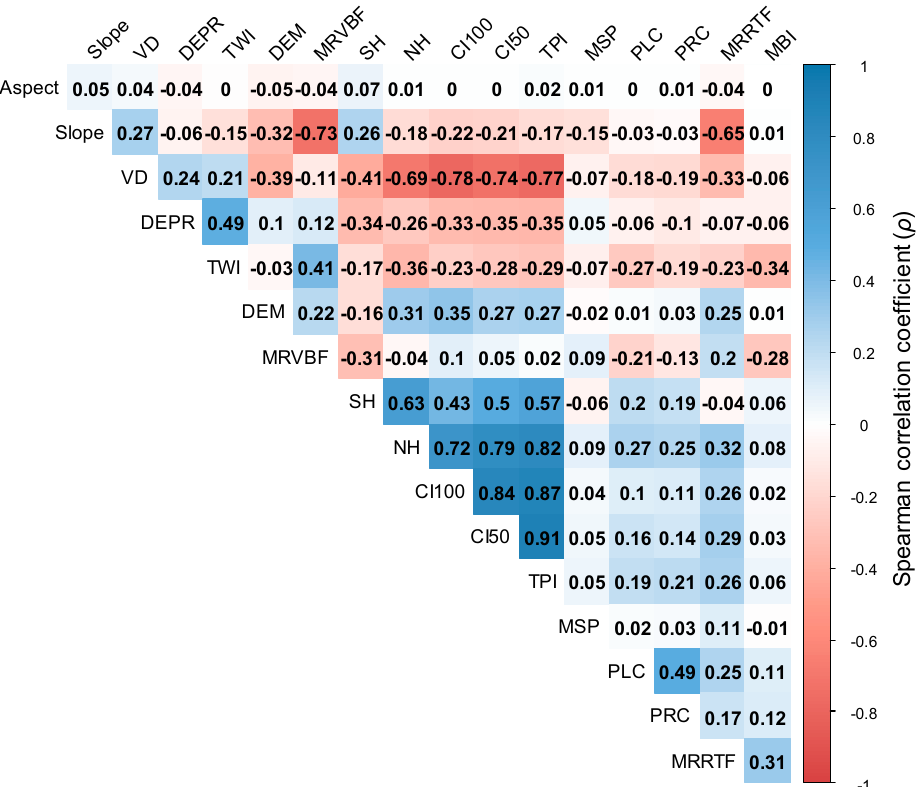
Figure 4. Summary of Spearman correlation coefficient analysis of geomorphometric indices.